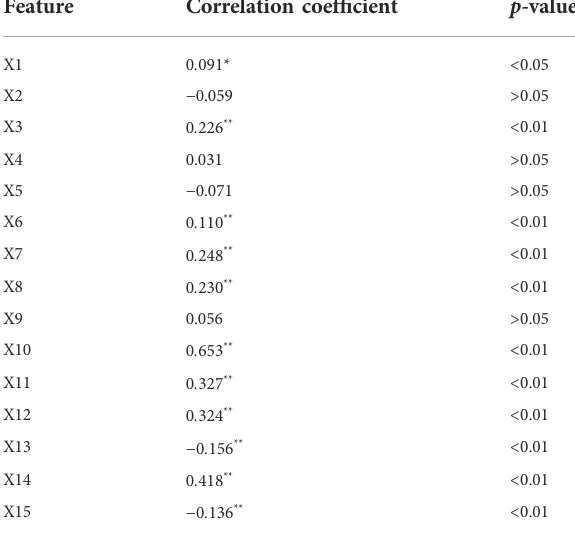
TABLE 3 Correlation of the predictor with the predicted